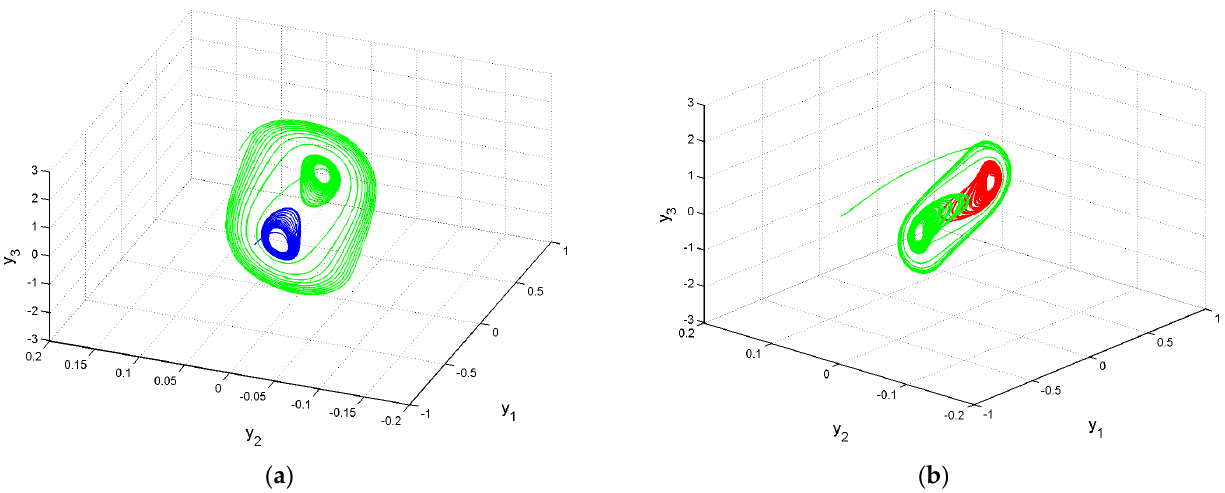
( b ) === ρδγ =ξ Figure 3. Phase graphs of the system (3) with 200,100,1.0 and: ( a ) 4.3 using Figure 3. Phase graphs of the system (3) with γ = 0.1, δ = 100, ρ = 200 and: ( a ) ξ = 3.4 using the the initial conditions T ]3.0,1.0,4.0[ (green domain) and T ]3.0,02.0,4.0[ −− (blue domain); ( b ) initial conditions [ 0.4, 0.1, 0.3 ] T (green domain) and [ − 0.4, 0.02, − 0.3 ] T (blue domain); ( b ) ξ = 2.85 85.2 =ξ using the initial conditions T ]3.0,1.0,4.0[ −− (green domain) and T ]3.0,01.0,4.0[ using the initial conditions [ − 0.4, 0.1, − 0.3 ] T (green domain) and [ 0.4, 0.01, 0.3 ] T (red domain). (red domain).